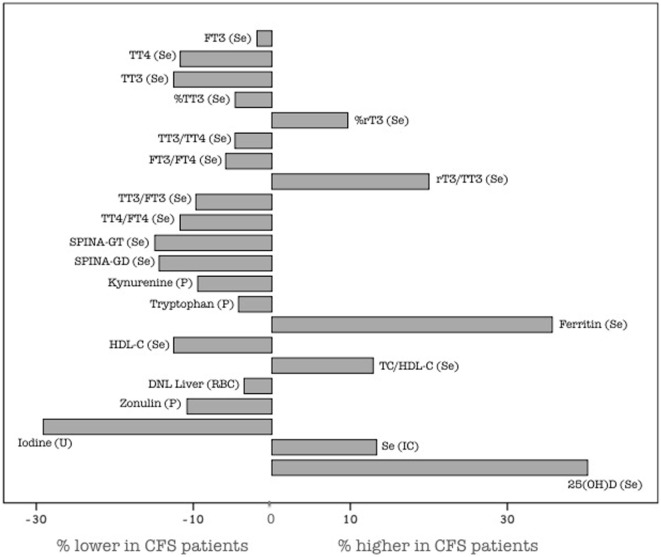
Between-group differences in parameters, depicted as percentages relative to control. Only parameters exhibiting significant between-group differences are depicted (see Table 1). Data are calculated from the medians (Table 1) according to [(median CFS − median controls)/median controls × 100] (in %). Se, serum; P, plasma; IC, intracellular; U, urinary; FT4, free thyroxin; FT3, free T3; TT4, total T4; TT3, total T3; rT3, reverse T3; TC, total cholesterol; HDL-C, high-density lipoprotein-cholesterol; DNL, de novo lipogenesis, sum of 16:0, 16:1ω7, 18:1ω7, 20:1ω7, 18:1ω9, 20:1ω9, and 22:1ω9, according to Ref. (61); SPINA-GD, sum activity of deiodinases; SPINA-GT, secretory capacity of the thyroid gland; sTSHi, standard TSH index.